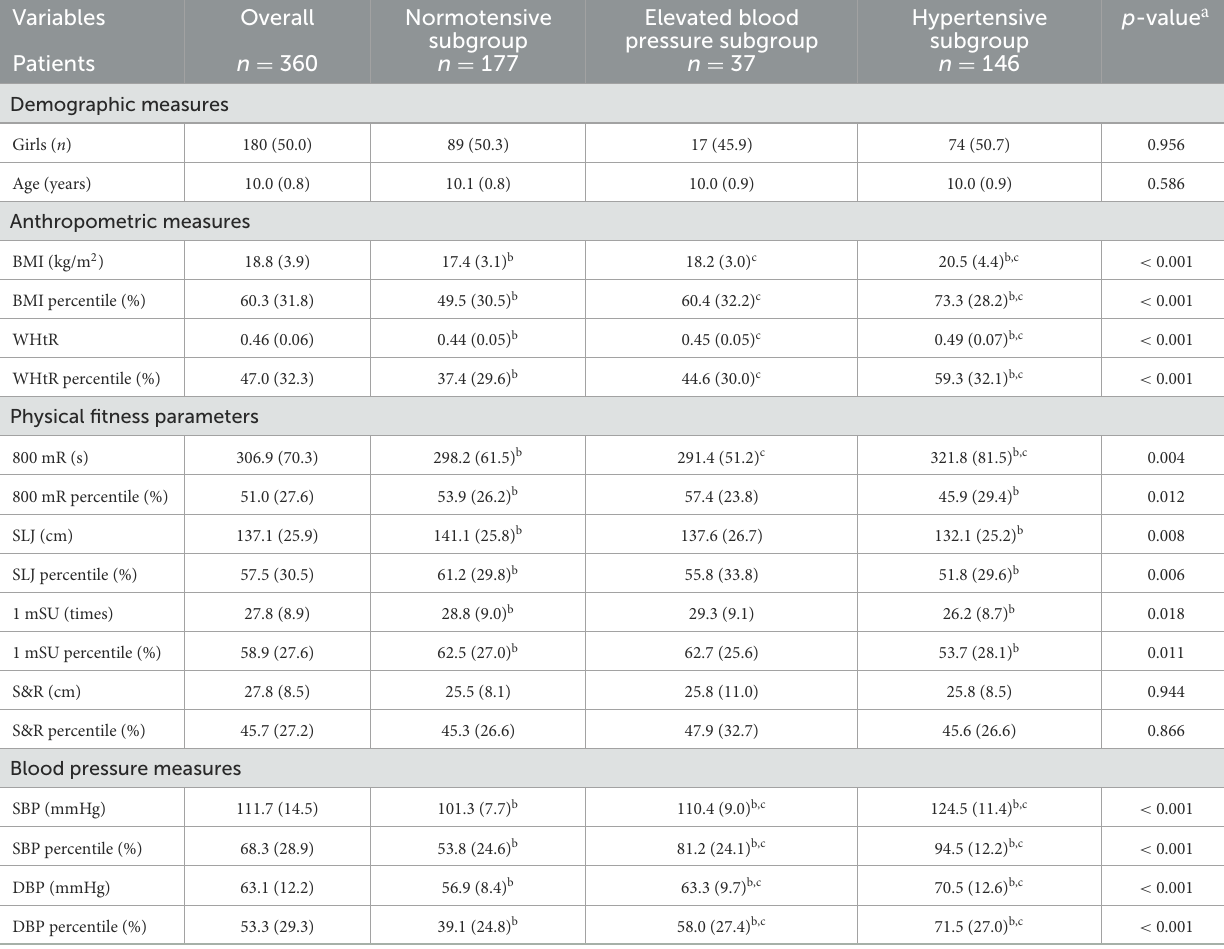
TABLE 1 Demographic, anthropometric, physical fitness, and blood pressure measures of the overall cohort as well as normotensive, elevated blood pressure, and hypertensive subgroups. Variables Overall Normotensive